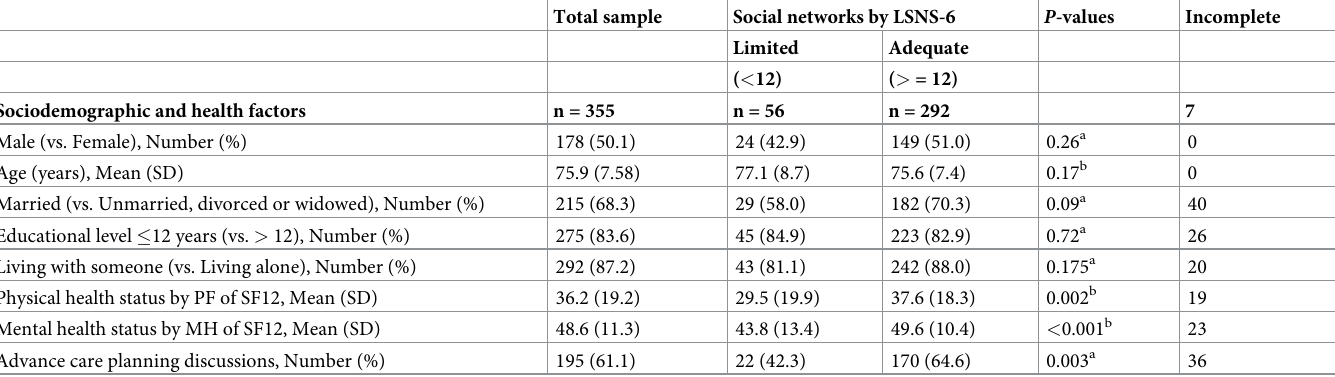
Table 1. Sociodemographic and health characteristics of the respondents.